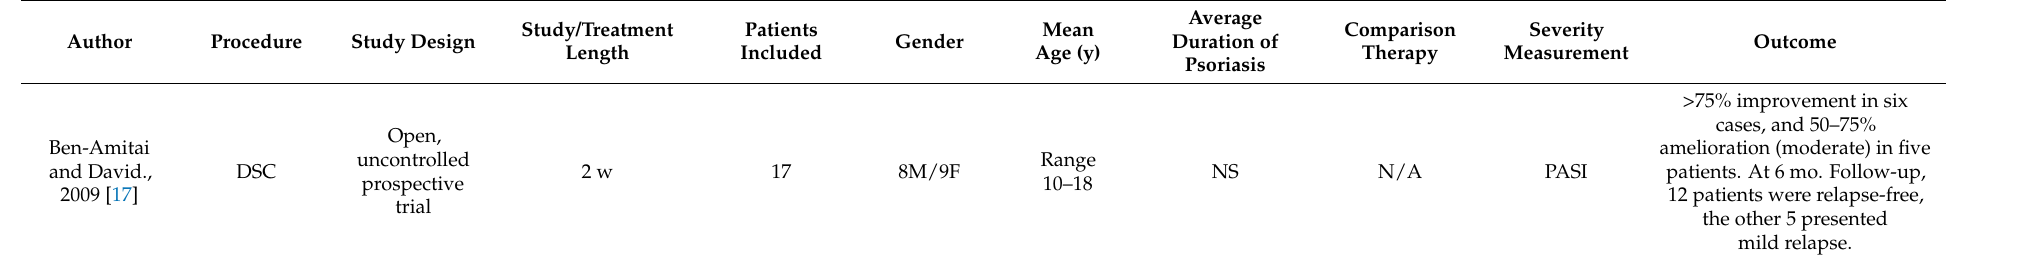
Table 4. Trials and case reports of patients undergoing balneotherapy and climatotherapy for psoriasis (arranged in order of